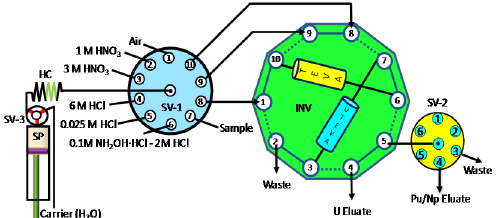
Figure 6. Schematic depiction of a sequential system (SI) incorporating a tandem-column for multi- radionuclide (Pu, Np and U) determination [63]. HC: holding coil, INV: injection vale, SV: selection valve, SP: syringe pump.